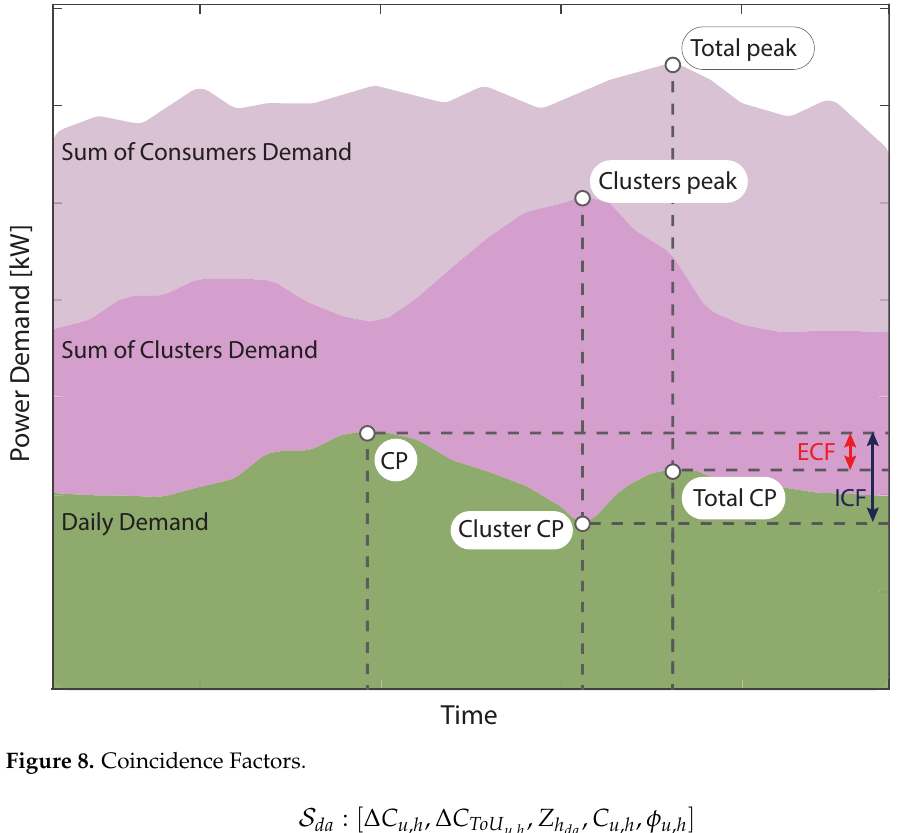
Figure 8. Coincidence